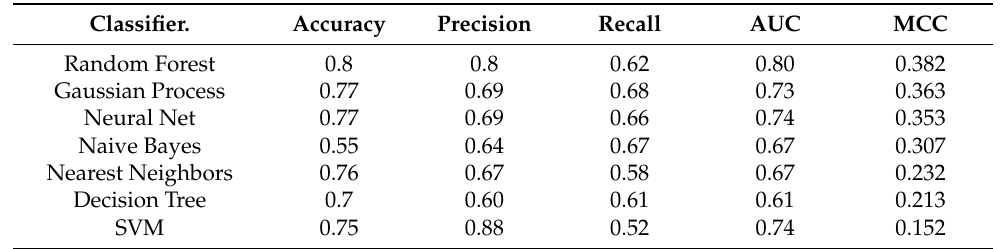
Figure 2. ROC curves for predicting effects on the catalytic efficiency of hydrolases by residue mutation. ( a ) The ROC curve of different classifiers on the five-fold cross-validation set. ( b ) The ROC curve on the five-fold cross-validation set and test set by the random forest model. Table 2. Prediction of effects on the catalytic efficiency of hydrolases by residue mutation on vali- dation and test set by random forest model.